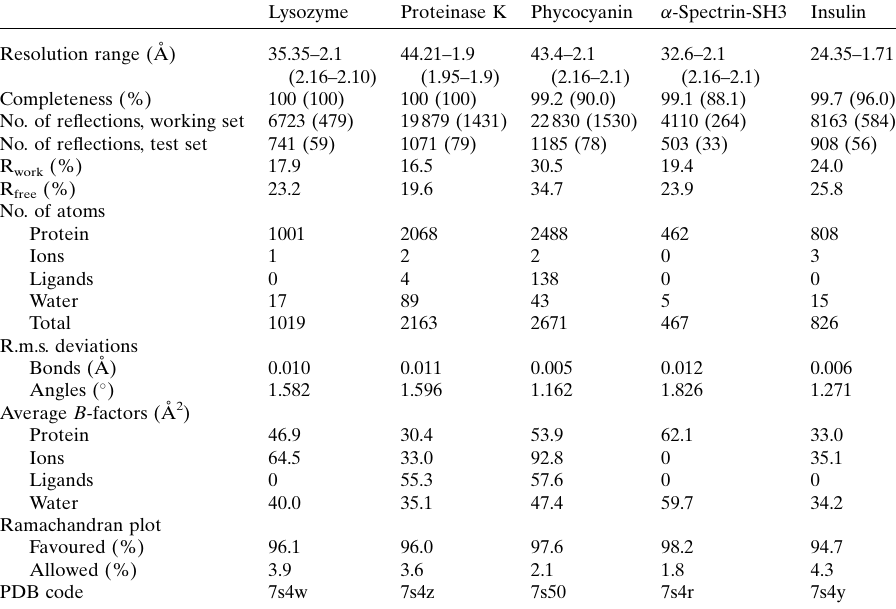
Table 2 Data refinement statistics (values in parentheses are for the high-resolution